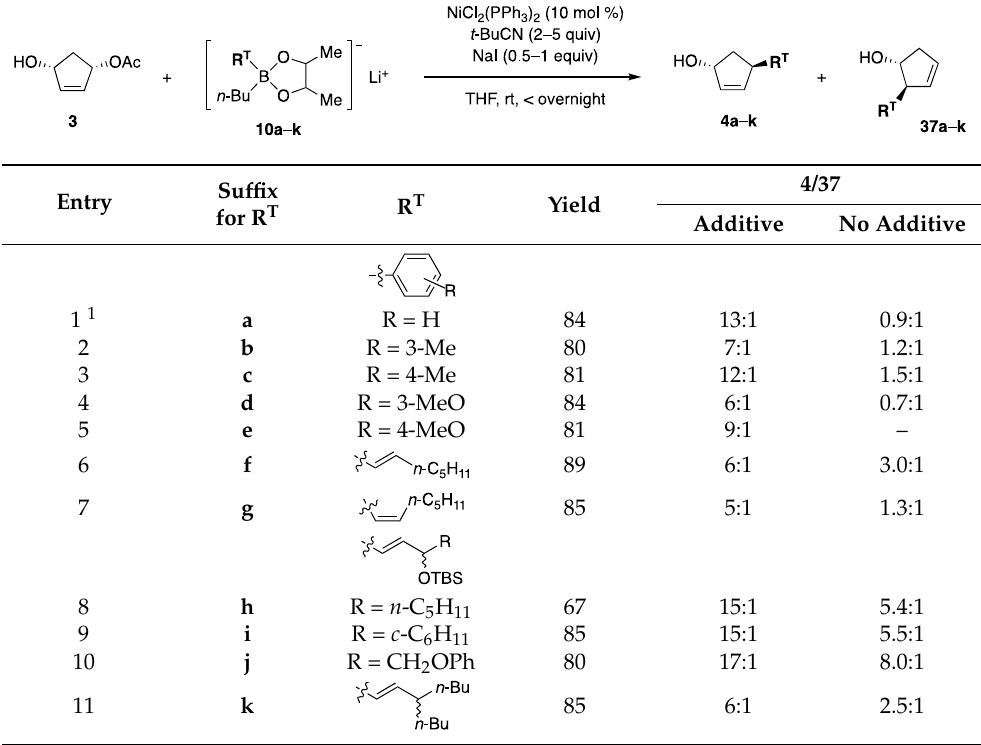
Table 3. Coupling reaction of cyclopentenyl acetate 3 with borates 10 .